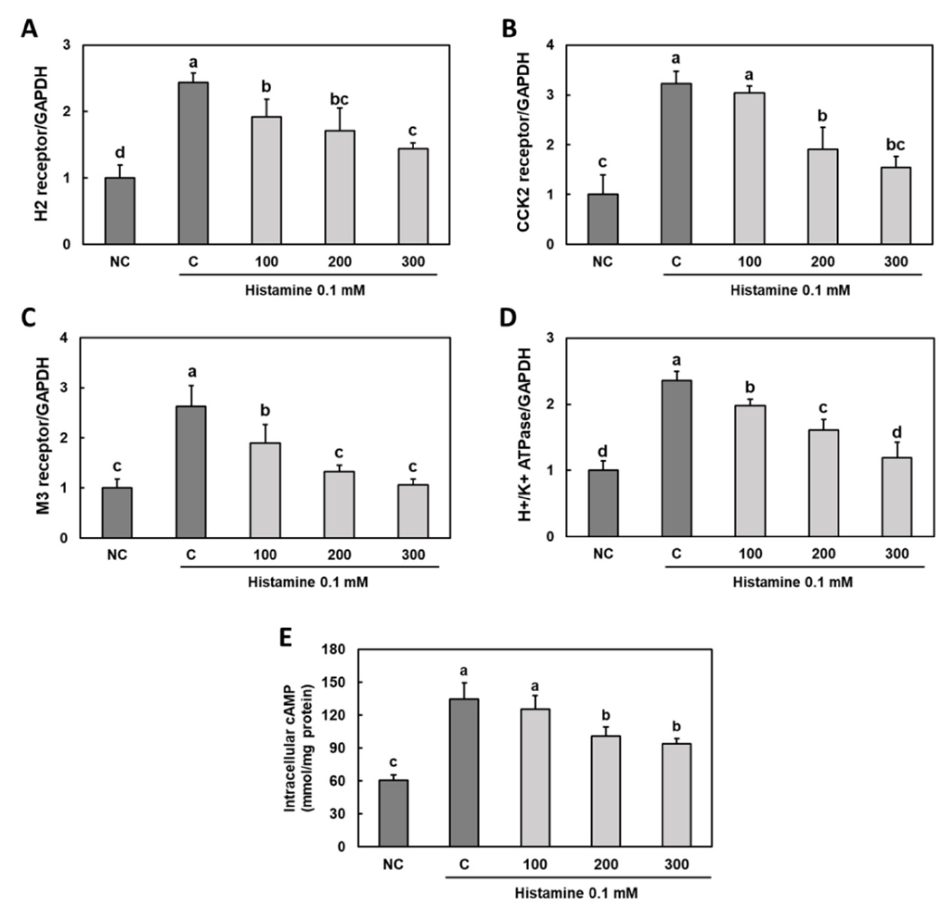
Figure 3. Effect of Gastro-AD ® on the expression of gastric acid secretion-related receptors in histamine-treated primary gastric parietal cells. The mRNA levels of ( A ) histamine-induced histamine 2 receptor (H2r), ( B ) gastrin-induced cholecystokinin 2 receptor (CCK2r), ( C ) acetylcholine-induced muscarinic acetylcholine receptor M3 (M3r), ( D ) H + /K + ATPase and ( E ) intracellular cAMP. Normal control (NC; − 0.1 mM histamine); 0.1 mM histamine control (C); 0.1 mM histamine with 100 µ g/mL of Gastro-AD ® (100); 0.1 mM histamine with 200 µ g/mL of Gastro-AD ® (200); and 0.1 mM histamine with 300 µ g/mL of Gastro-AD ® (300). Values are presented as mean ± SD ( n = 3). Different letters indicate a significant difference, with p < 0.05, as determined using Duncan’s multiple range test.